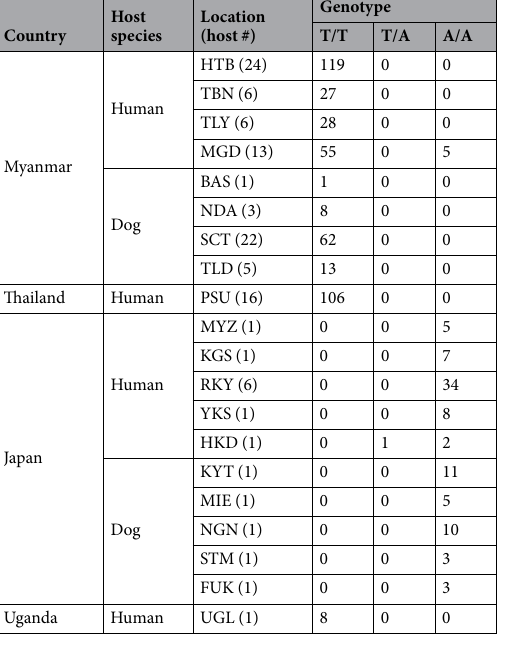
Table 2. Genotypes of 18S rDNA 458T/A polymorphism Genotypes for the polymorphism at position 458 of the reference sequence (AF279916; NCBI nucleotide database) were determined for S . stercoralis samples collected in the study.